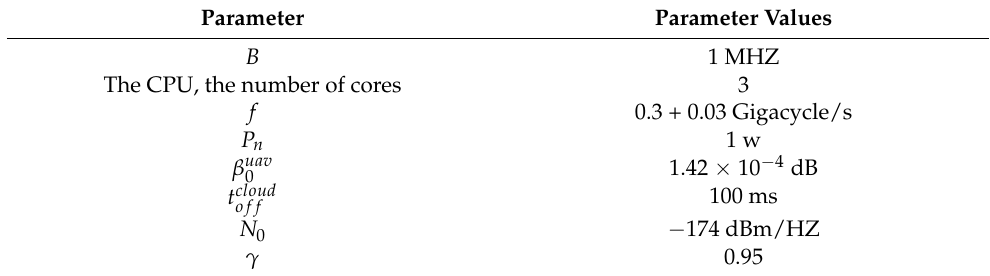
Table 1. Simulation parameters.